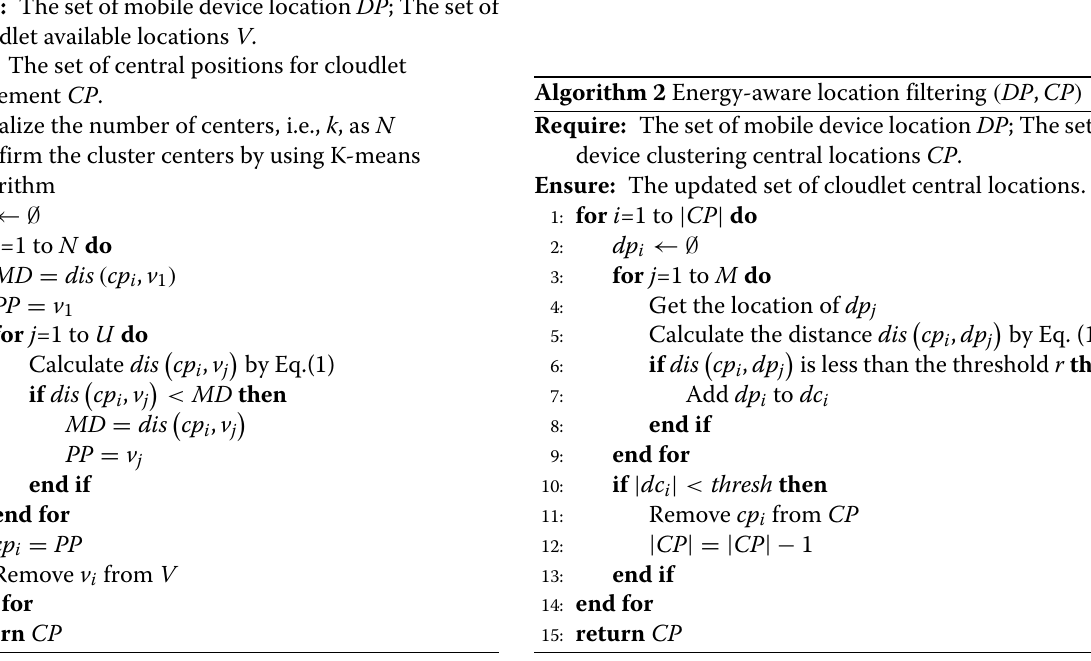
Algorithm 1 Center position recognition ( DP , V )